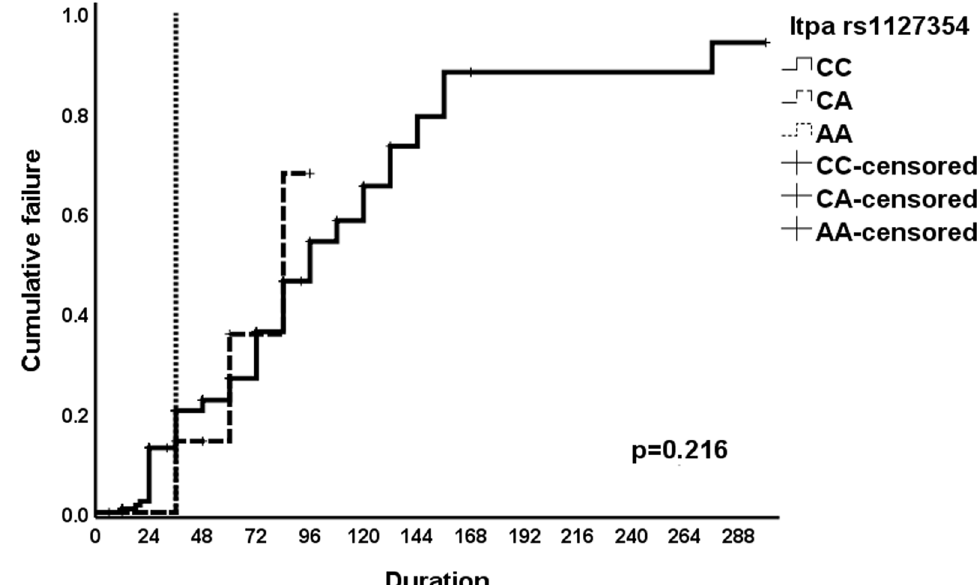
Fig. 4 Time to failure according to rs1127354 genotypes